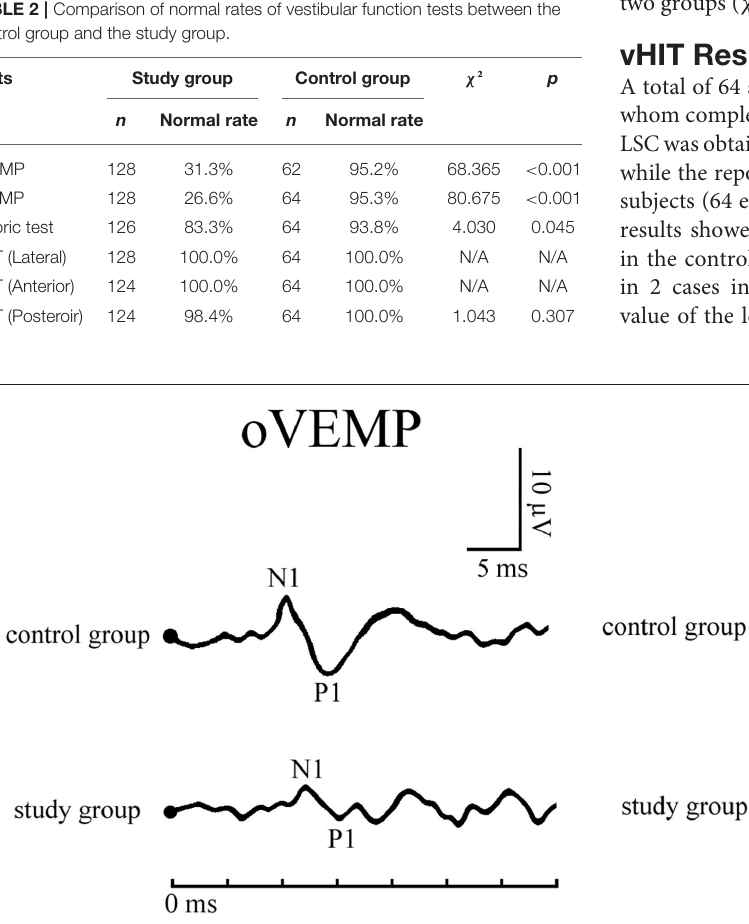
Frontiers in Neurology |